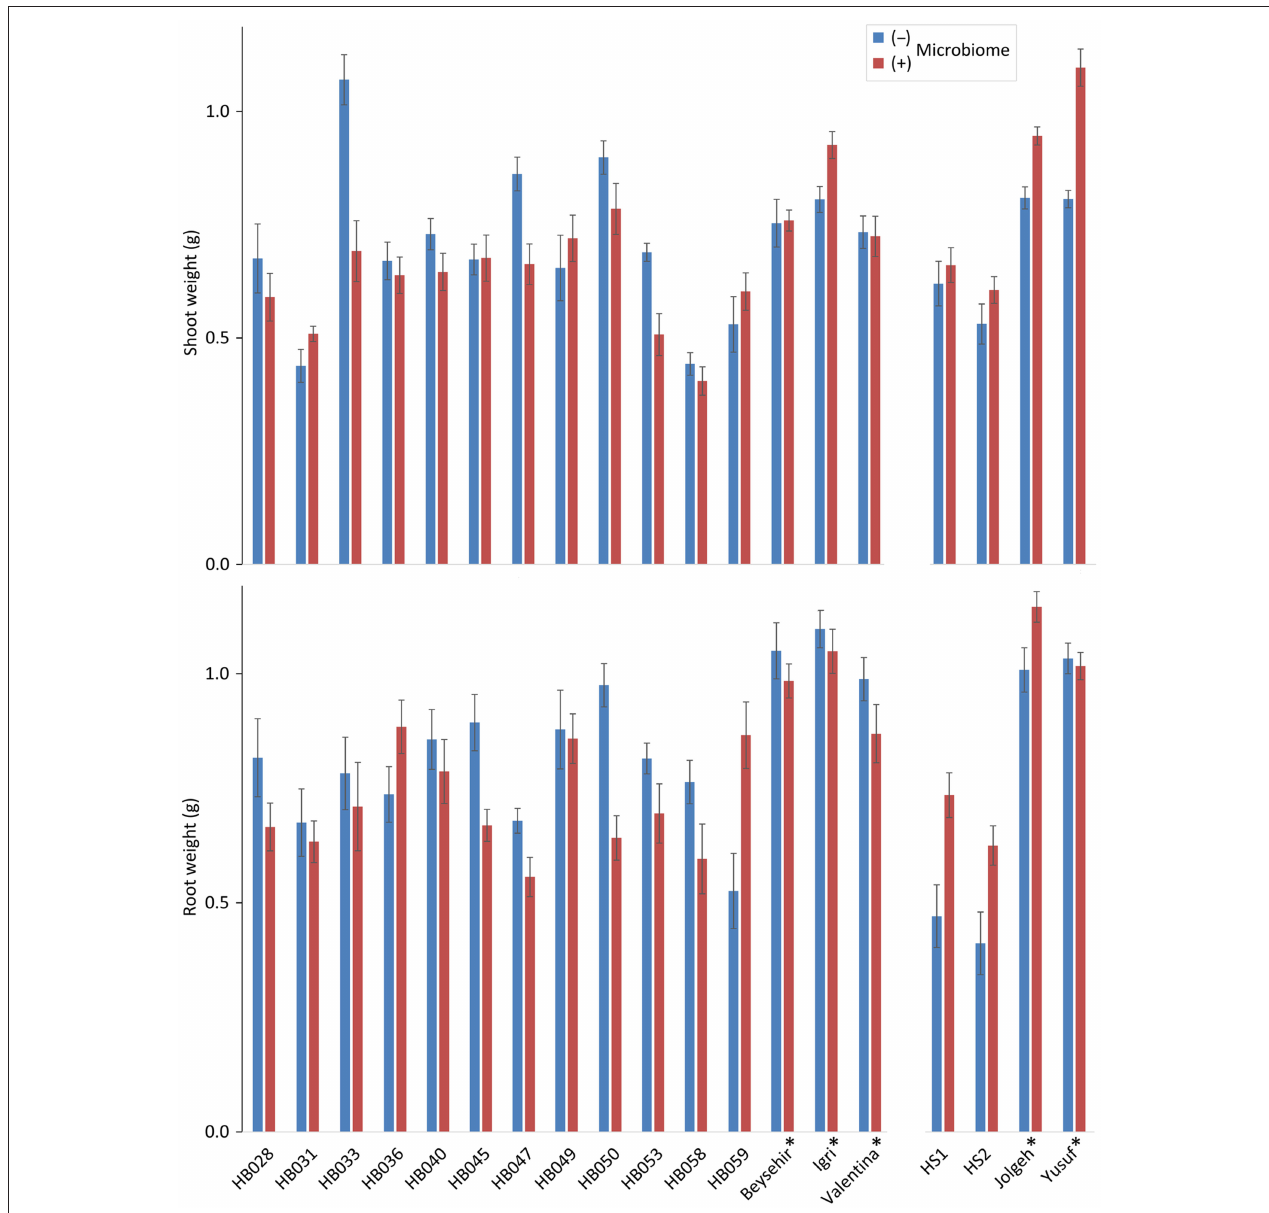
FIGURE 1 | Responsiveness of elite cultivars (indicated by a star) and ancestral genotypes of barley to rhizosphere microbiomes regarding plant growth in the presence of root-lesion nematodes, Pratylenchus neglectus . Mean shoot and root weights from the genotypes used in the two independent experiments are separated on the horizontal axis. Error bars indicate SE ( n = 12 plants with ( + ) and 12 plants without (–) inoculated microbiome per genotype of barley).